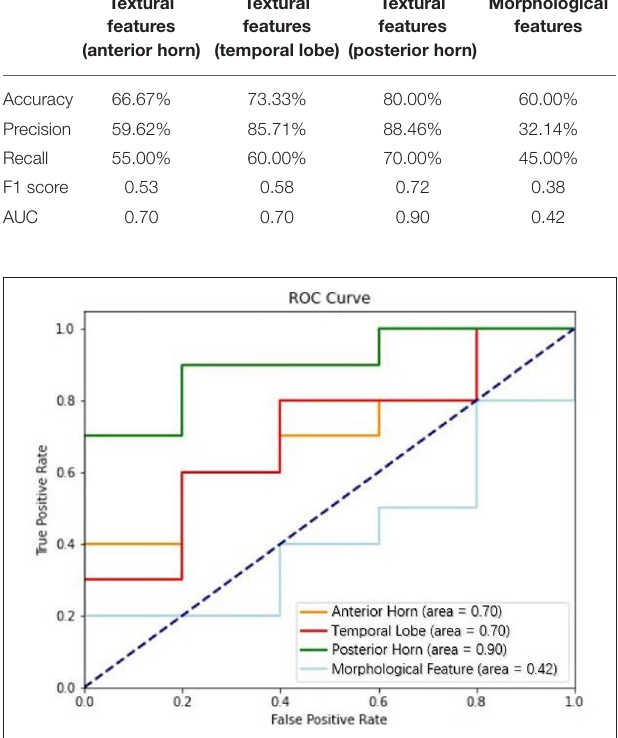
FIGURE 3 | Performance of models based on textural features (anterior horn, temporal lobe, and posterior horn) and morphological features in discriminating intracranial hypertension; the AUCs for these models were 0.70, 0.70, 0.90, and 0.42,